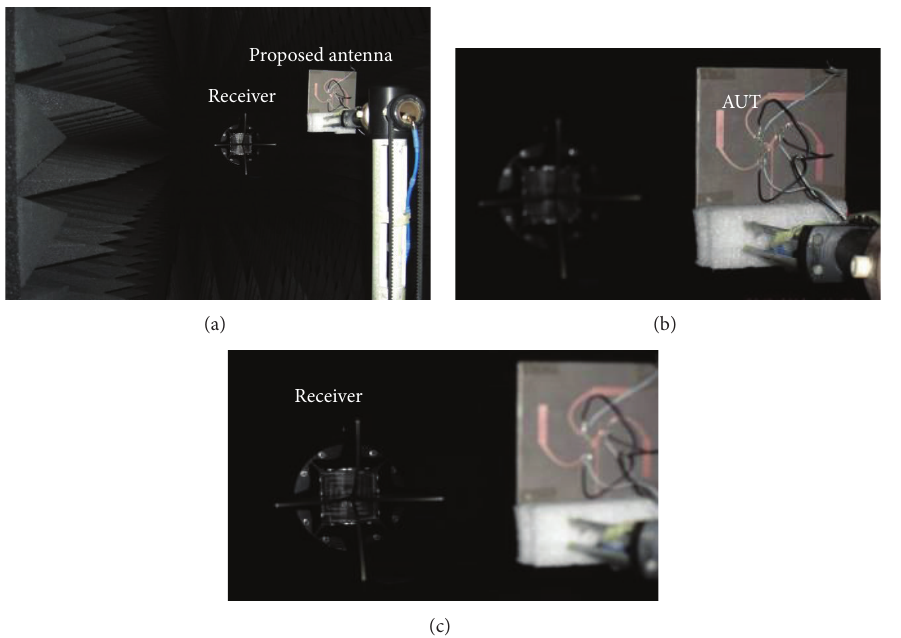
Figure 6: Positions of the proposed antenna in the anechoic chamber. (a) Point-to-point positioned. (b) The proposed antenna. (c) Receiver (double ridged horn)